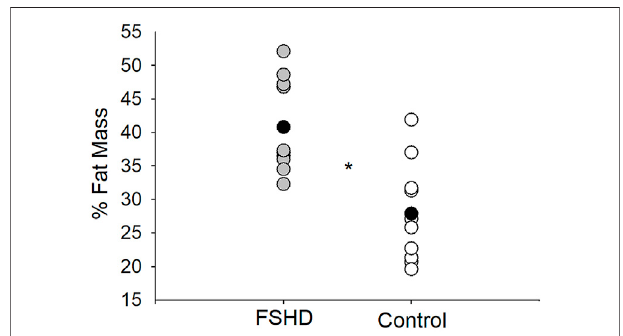
FIGURE 3 | % lean mass in FSHD and controls. Individuals with FSHD had a lower % lean mass, as compared to controls. Black circles indicate average data for each group. * p <